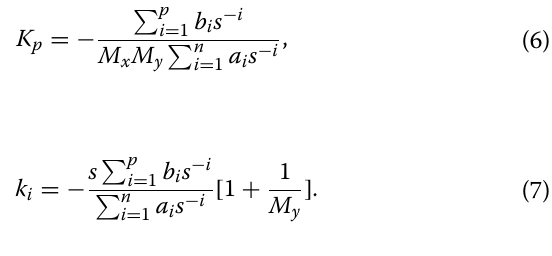
(cid:31) y is the bending displace-